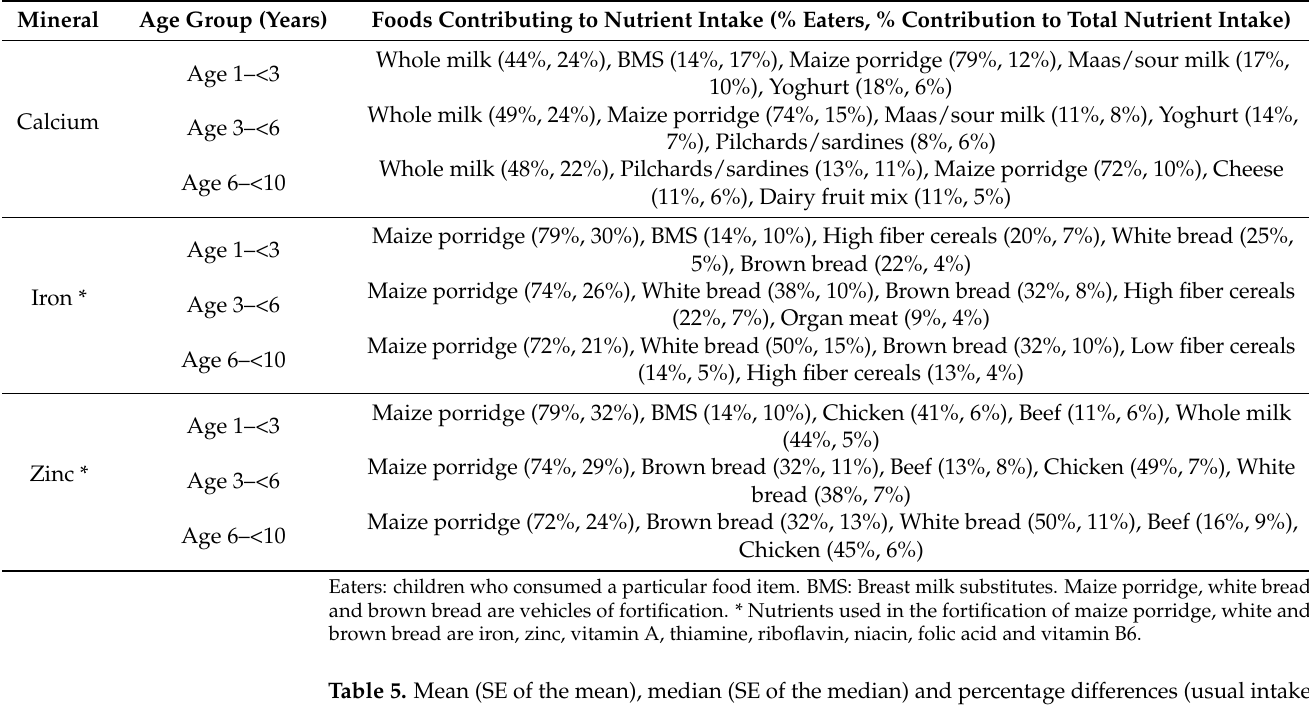
Table 5. Mean (SE of the mean), median (SE of the median) and percentage differences (usual intake versus Day-1 intake) for vitamins A, C, D and E by age